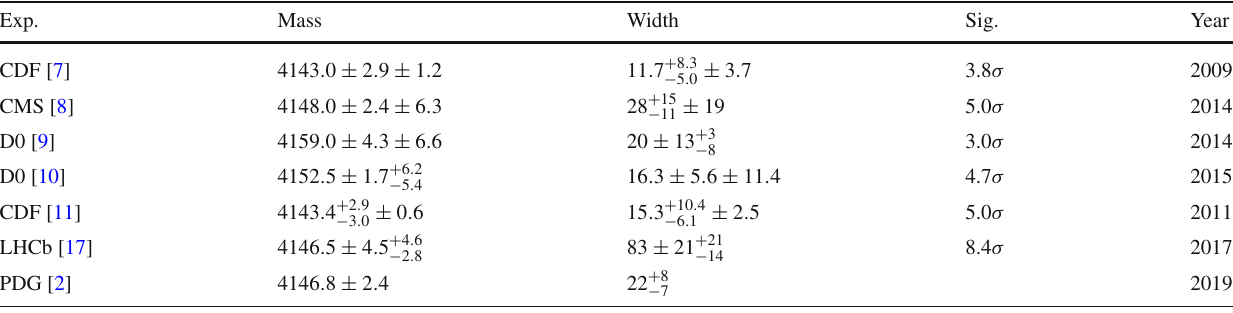
Table 1 The experimental measurements of the X ( 4140 ) (in MeV) Exp. Width Sig.